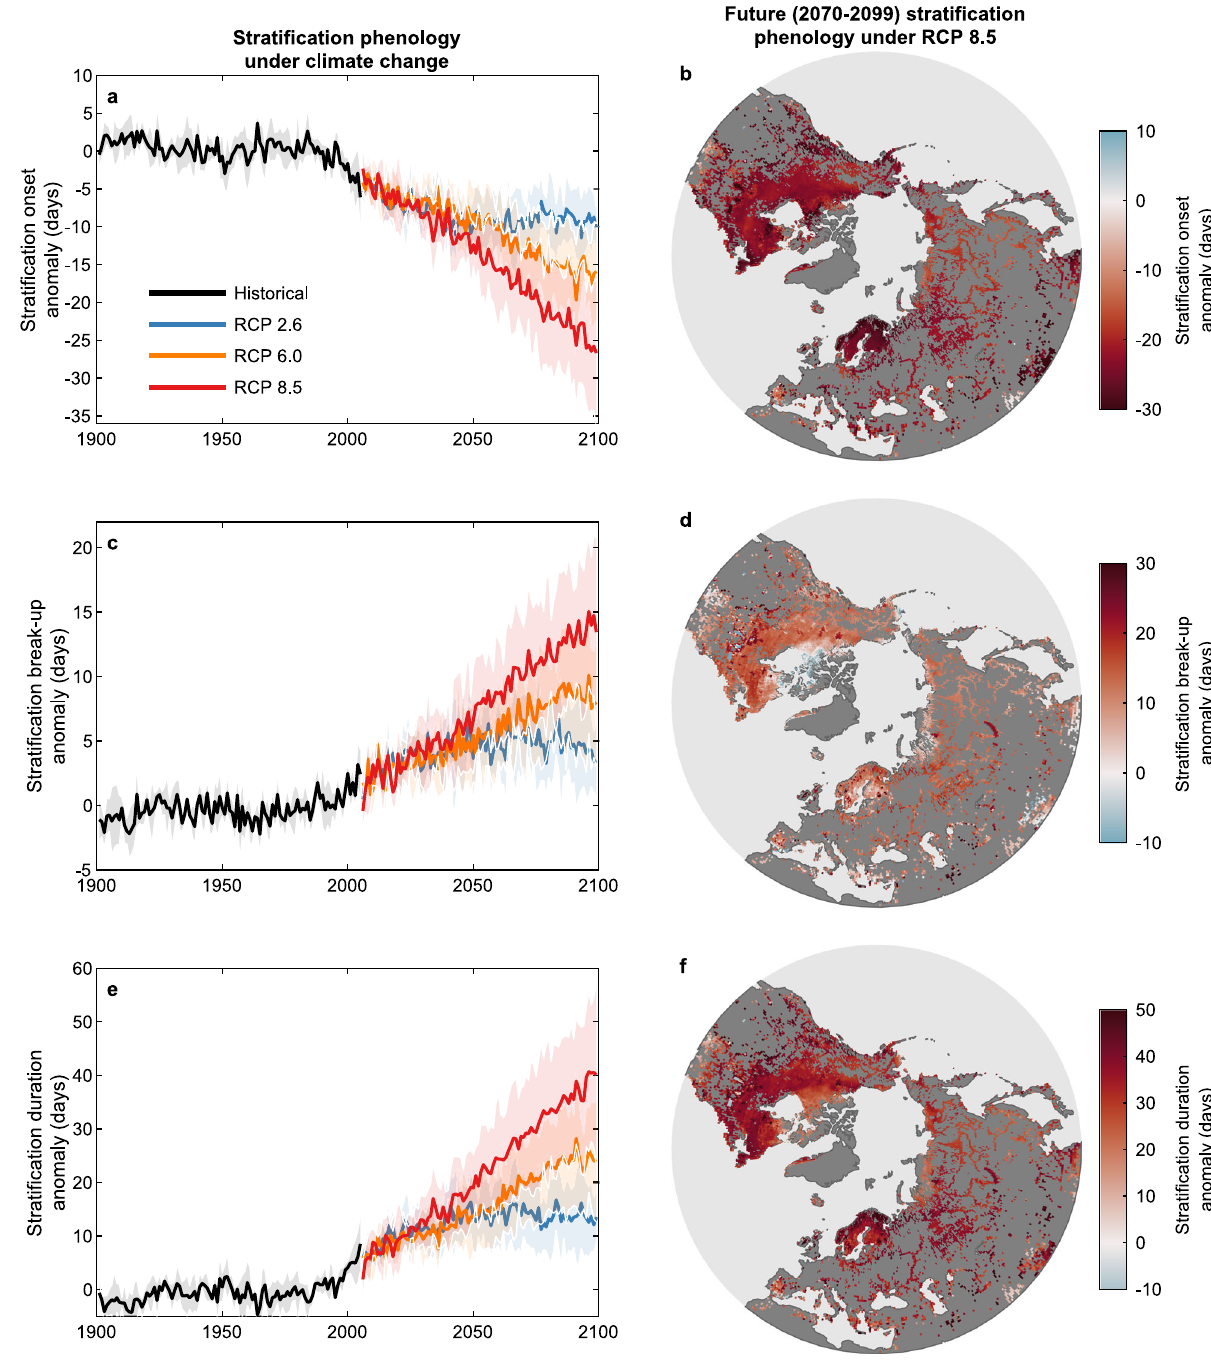
Fig. 4 Historic and future projections of lake strati fi cation phenology. Temporal and spatial variations in a , b the onset and c , d the break-up of thermal strati fi cation, as well as e , f the duration of the thermally strati fi ed period. The temporal changes in lake strati fi cation phenology are shown a , c , e from 1901 to 2099 under historic and future climate forcing (RCP 2.6, 6.0, 8.5). The thick lines show the average across all lake – climate models, and the shaded regions represent the standard deviation across the model ensemble. b , d , f show the spatial patterns in strati fi cation phenology anomalies by the end of the twenty- fi rst century (averaged over all years from 2070 to 2099) under RCP 8.5. Anomalies are quoted relative to the 1970 – 1999 base-period